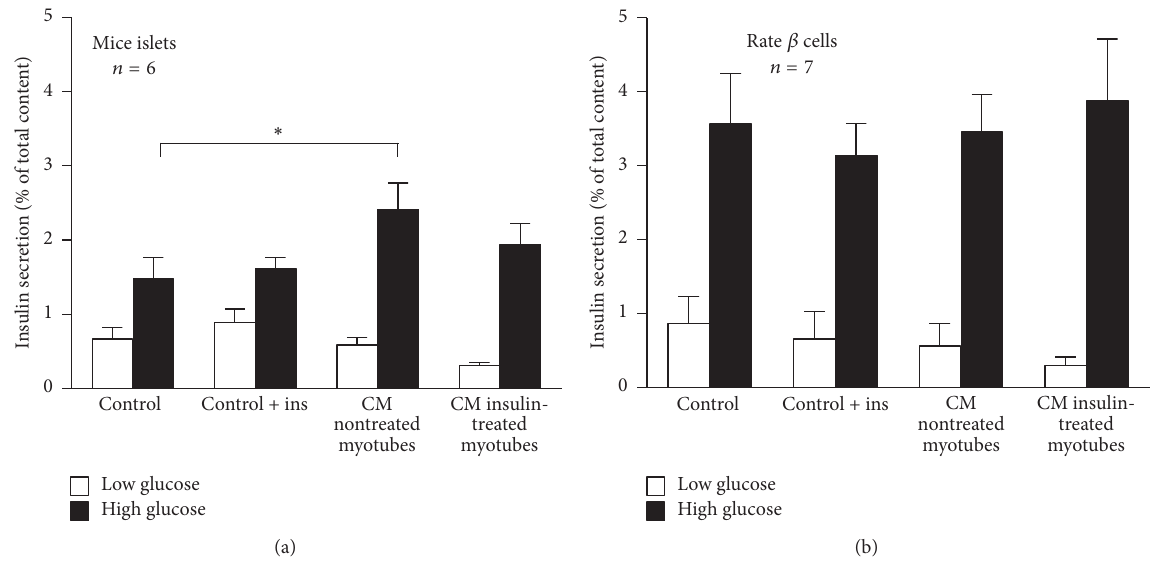
Figure 4: Effect of conditioned media from noninsulin- and insulin-treated myotubes on glucose-stimulated insulin secretion. Insulin secretion in isolated mice islets (a) and primary rat beta cells (b). Islets and beta cells were incubated with conditioned media from nontreated and insulin-treated myotubes for 24h before hormone secretion assessment. Controls are unconditioned media without/with added insulin (100nmol/L). Low glucose = 2.8 mmol/L glucose and high glucose = 16.7 mmol/L glucose. Mean ± SEM. ∗ 𝑝 < 0.05 , two-way ANOVA with Tukey post hoc test.